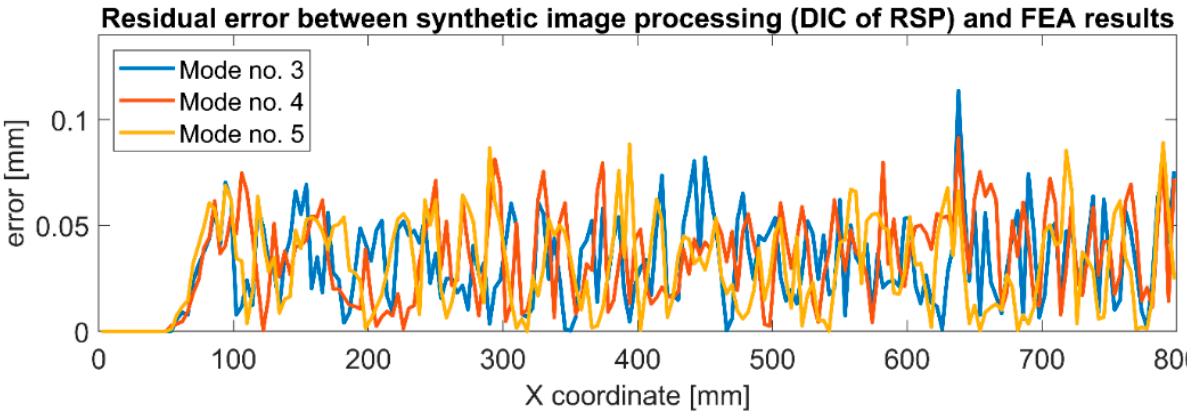
Table 3. Statistical parameters of residual error between synthetic images processing and FEA results for different mode